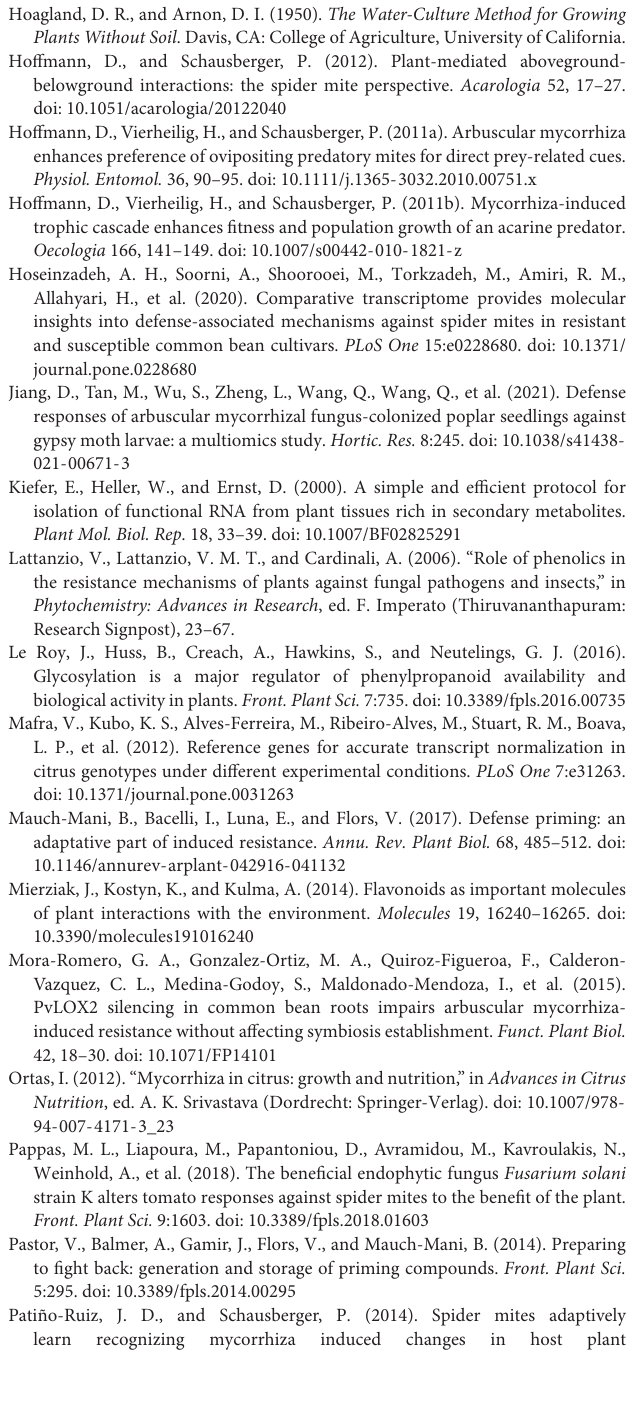
systemic leaves. Three treatments: AM (mycorrhizal plants with only the second infestation); NM inf (non-mycorrhizal plants with local and systemic infestation); AM inf (non-mycorrhizal plants with local and systemic infestation, were compared to the control: NM (Non-mycorrhizal plants with only the second infestation). Different letters indicate significant differences between treatments. The assay was repeated a minimum of three times. Asterisks indicate significant differences at P < 0.05 one asterisk, P < 0.01 two asterisks, P < 0.001 three asterisks for generalized linear model (GLIM, n =